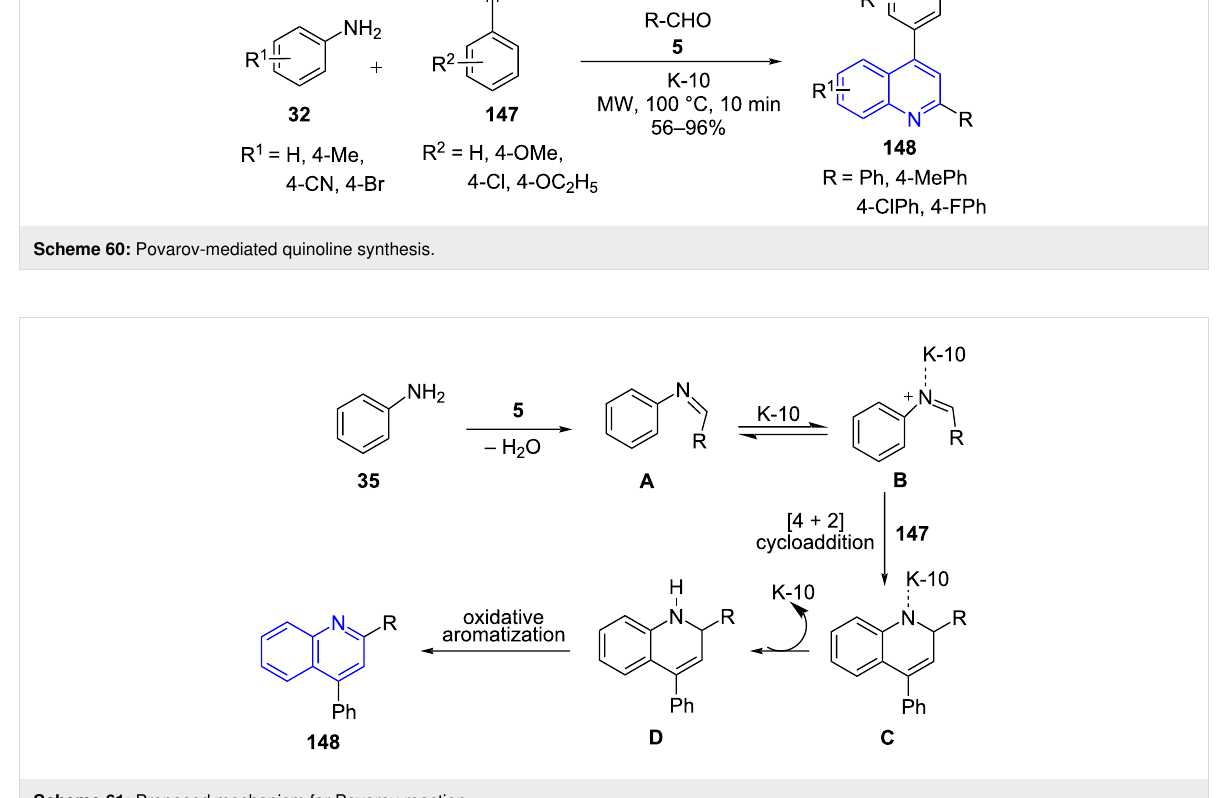
Scheme 61: Proposed mechanism for Povarov